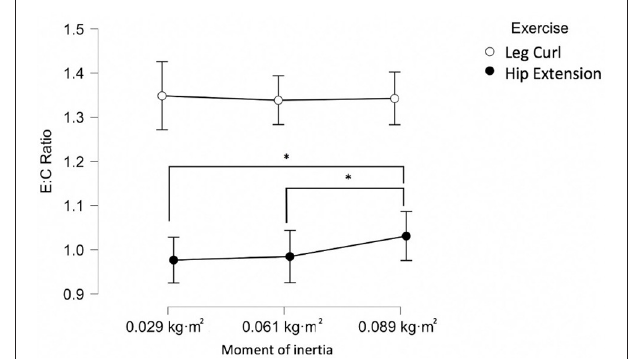
FIGURE 4 | The eccentric:concentric (E:C) ratio for unilateral flywheel leg curl and hip extension exercises. *Statistically significant ( p < 0.05) difference between E:C